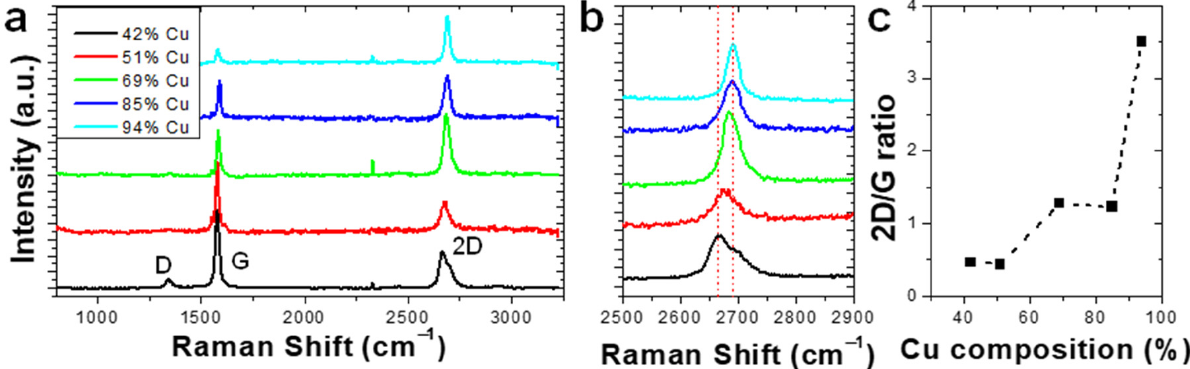
Figure 4. ( a ) Raman spectra of graphene grown on Cu x Ni 1 − x catalyst at regions with varying Ni concentrations. ( b ) Raman spectra of the graphene 2D peak. ( c ) 2D/G ratio of Raman spectra as a function of catalyst Cu composition.